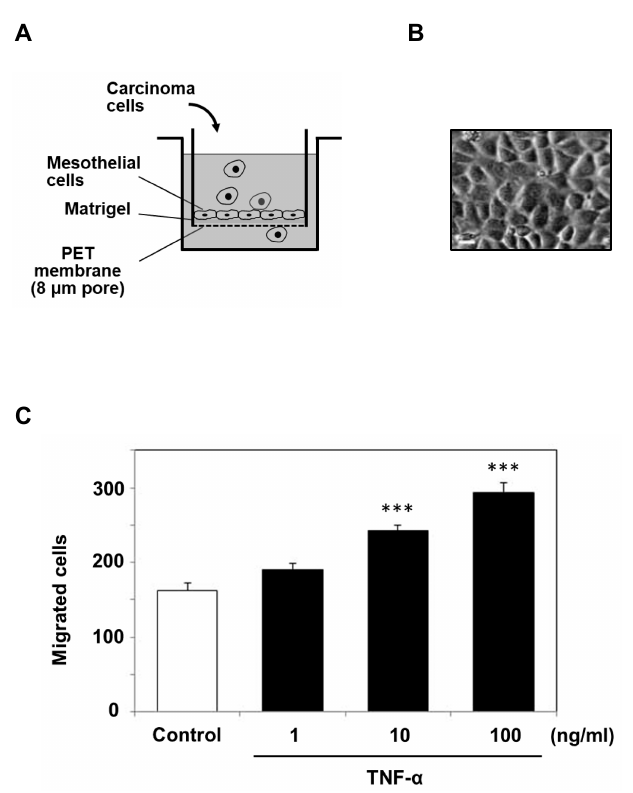
Figure 4. Cell invasion assay using a reconstituted artificial mesothelium in a Boyden chamber (Transwell) system. ( A ) The inner chamber with a membrane (8.0 µ m pore) was composed of a monolayer of peritoneal mesothelial cells on a Matrigel layer and was utilized to examine the migration of MKN1 cells. The outer chamber was filled with ASF104 medium supplemented with HT1080 serum-free conditioned medium as a chemoattractant. ( B ) Microscopic observation of a monolayer of mesothelial cells (scale bar = 20 µ m). ( C ) After mesothelial cells were treated with TNF- α (1, 10 or 100 ng/mL) and washed with ASF104 medium, MKN1 cells (1 × 10 5 cells/0.2 mL) were placed in the inner chamber and incubated at 37 ◦ C for 16 h. The cells migrating into the outer chamber through the membrane were counted under a microscope after staining with Diff-Quik. Experiments were performed in triplicate, and the data are presented as the mean ± SEM. Statistical data analysis